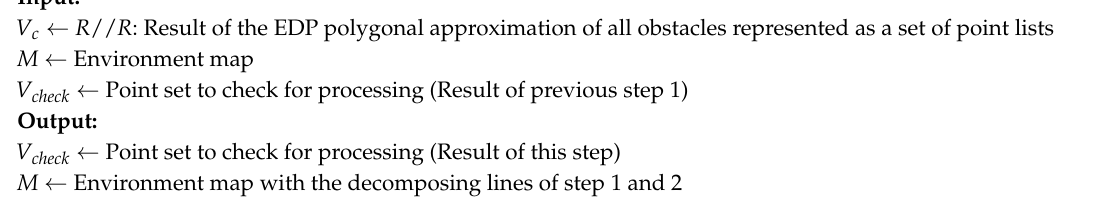
Algorithm 6. Pseudo Code of the modified OAECD (Step 2).